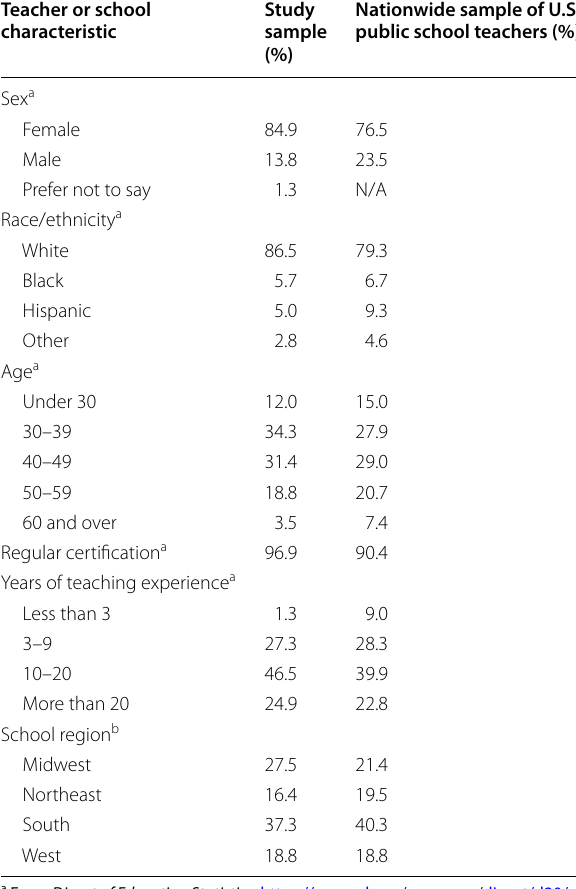
Table 1 Background characteristics of teachers in the present sample compared with a nationwide